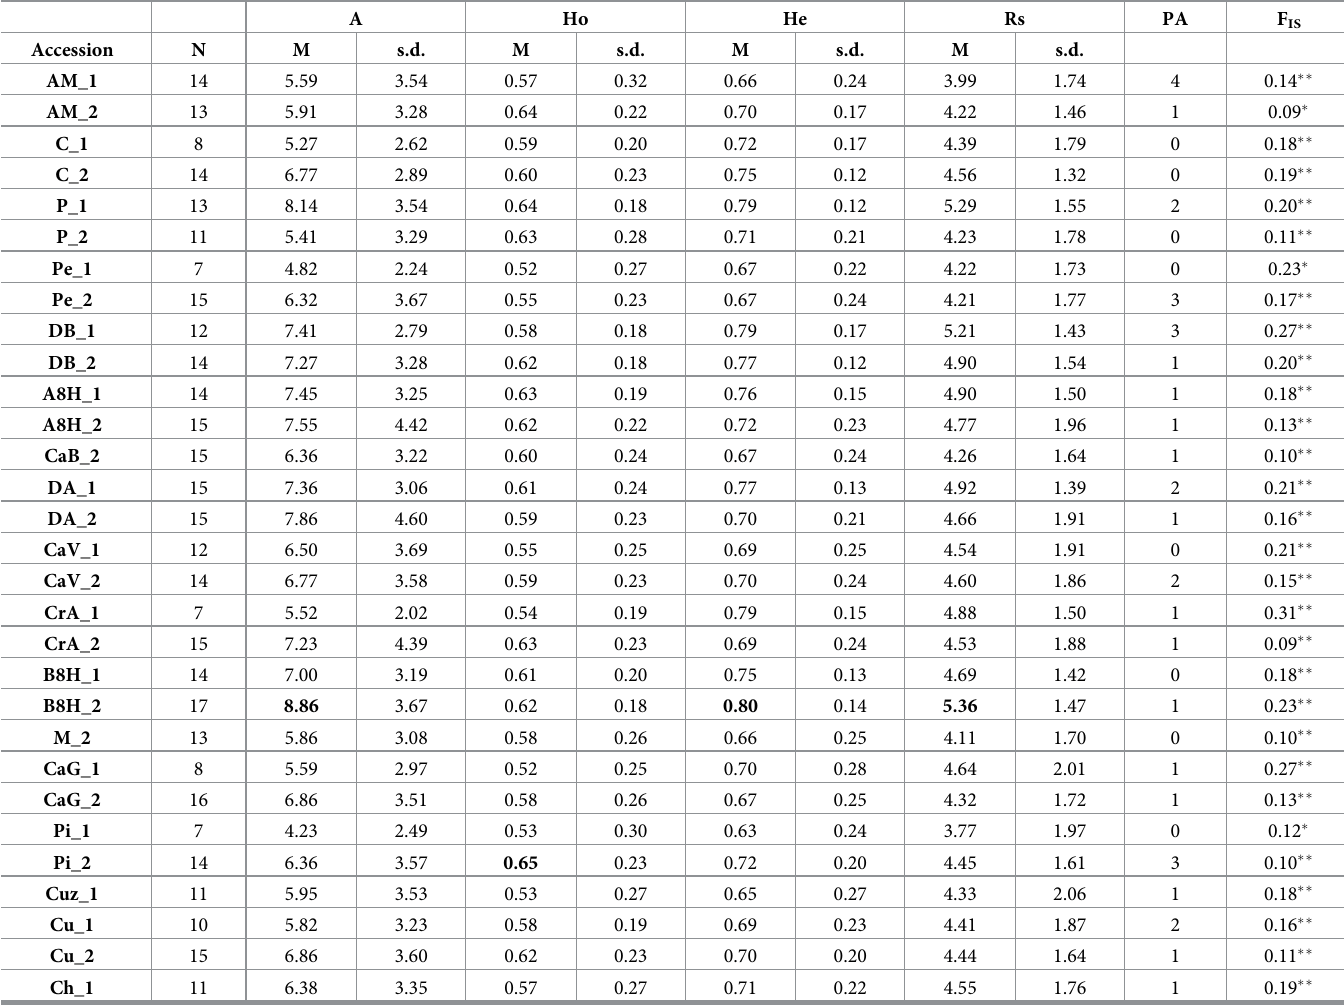
Table 2. Genetic variability in maize landraces from Northwestern Argentina (22 SSR